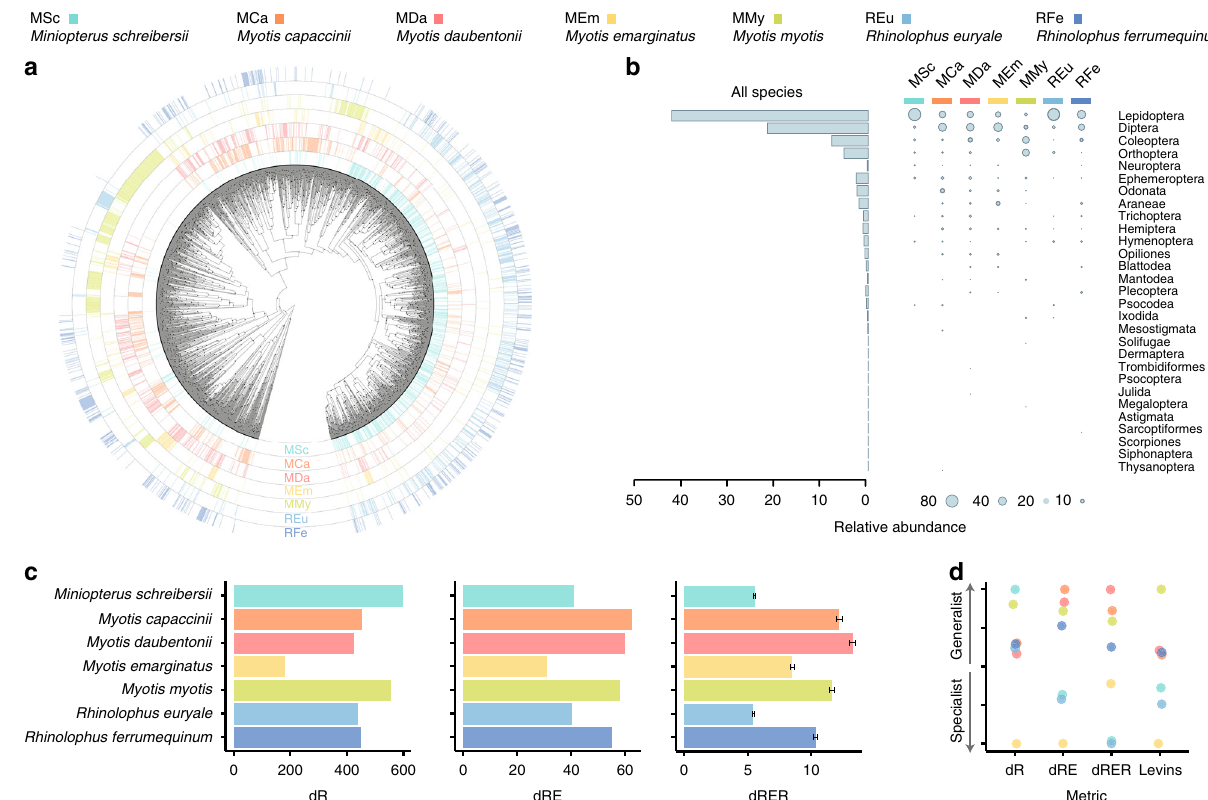
Fig. 1 Dietary diversity statistics of the analysed bat species. a Radial phylogenetic tree of prey detected using the Zeale primers and their occurrence patterns in each of the studied bats. A higher resolution image (Supplementary Fig. 1) and the homologous fi gure built from the Epp data (Supplementary Fig. 2) are available in the Supplementary Information. b Overall and predator species-speci fi c representation of the arthropod taxonomic orders. The incidence-based fi gure is available as Supplementary Fig. 4. c Dietary niche breadth measures accounting for richness (dR), richness + evenness (dRE) and richness + evenness + regularity (dRER). The error bars (±SE) of dRER indicate the dispersion of the dietary niche breadths yielded when using different prey phylogenetic trees ( N = 50) sampled from the Bayesian MCMC. d One-dimensional species ordination plots ranking species according to the dietary niche breadth based on different metrics. Levin ’ s index is also included for being the most common metric employed in the